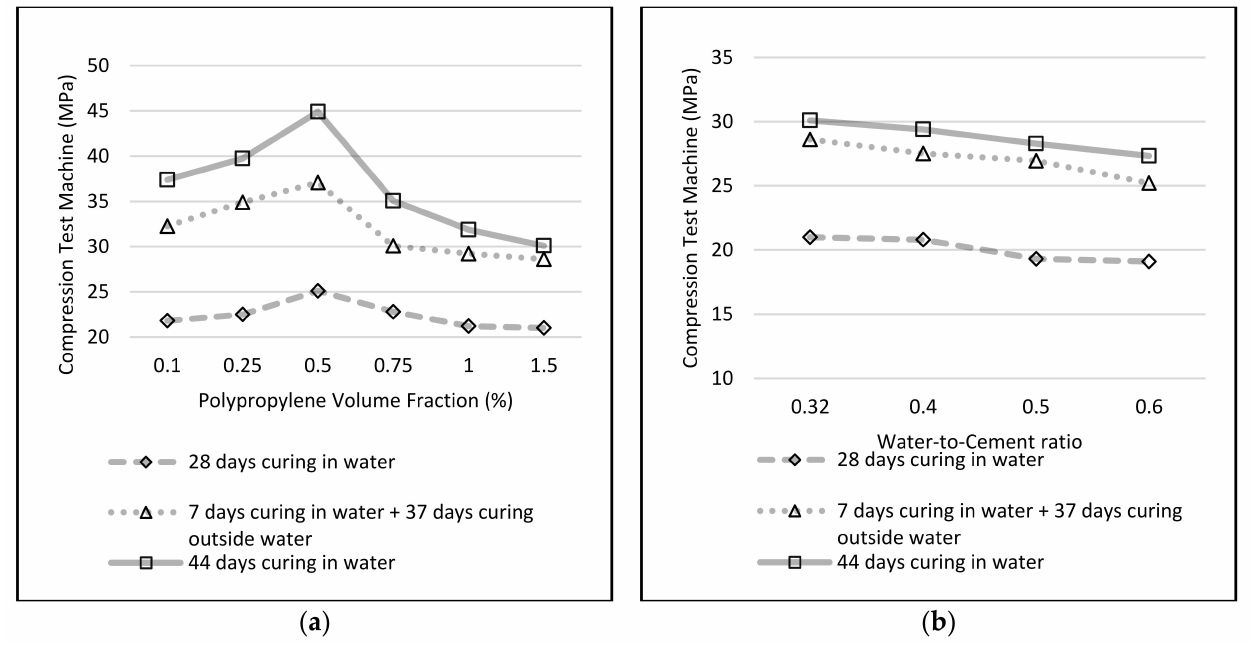
Figure 2. CTM values vs. polypropylene’s V f ( a ) and w/c ( b